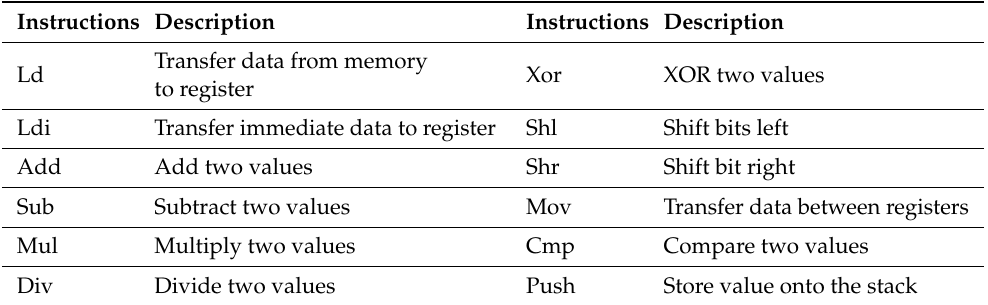
Table 6. CPU0 instruction